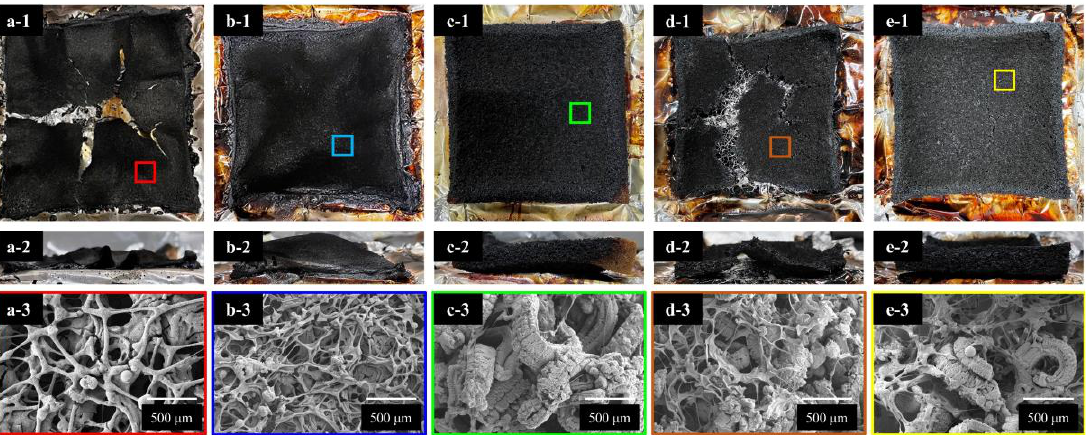
Figure 13. Digital photographs and SEM images of char residues of RPIF-0-0 ( a-1 )–( a-3 ), RPIF-0-15 ( b-1 )–( b-3 ), RPIF-15-0 ( c-1 )–( c-3 ), RPIF-5-10 ( d-1 )–( d-3 ), and RPIF-10-5 ( e-1 )–( e-3 ) after